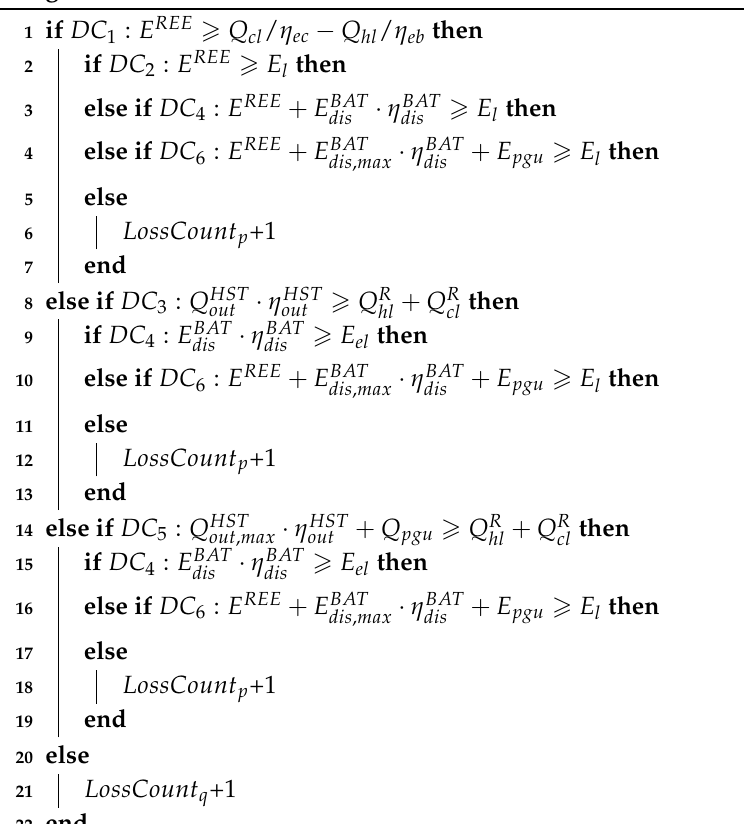
Algorithm 1: Flowchart of